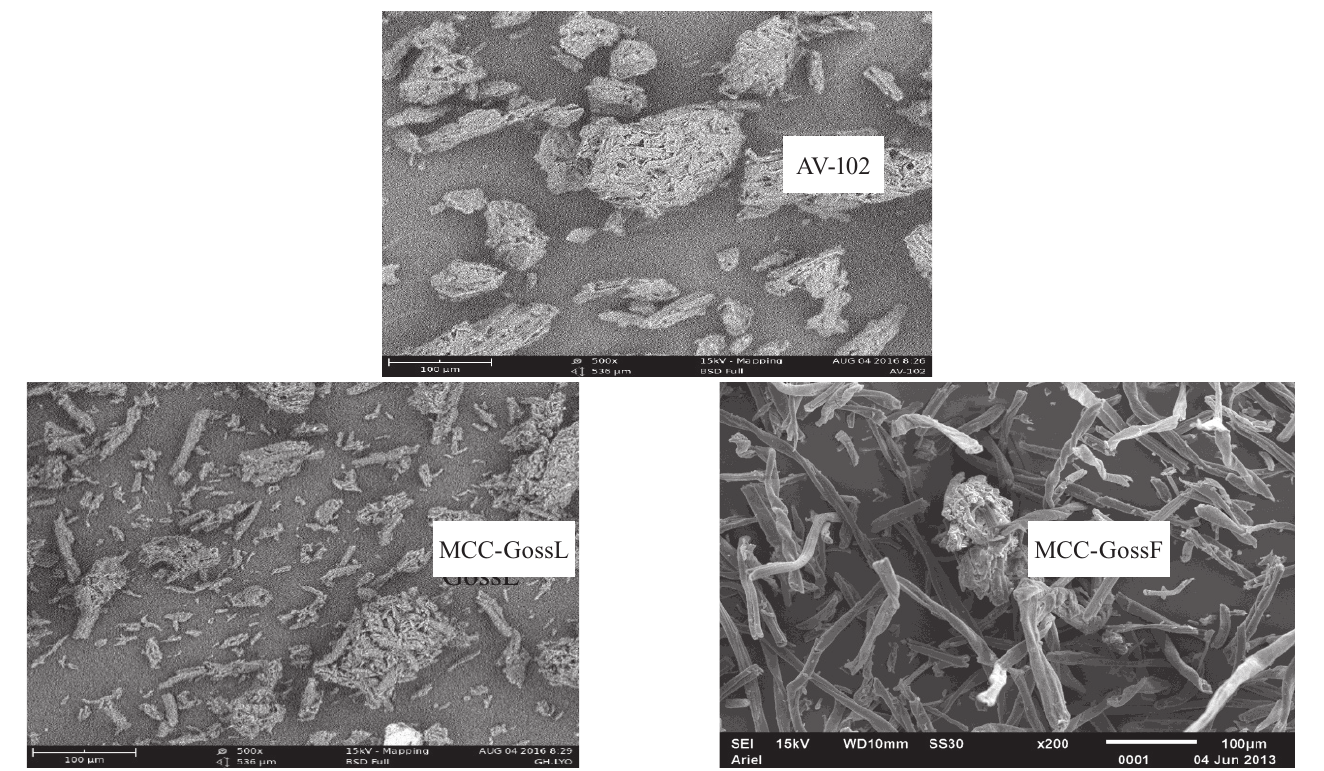
FIGURE 2 - Scanning Electron Micrographs of AV-102, MCC-GossL and